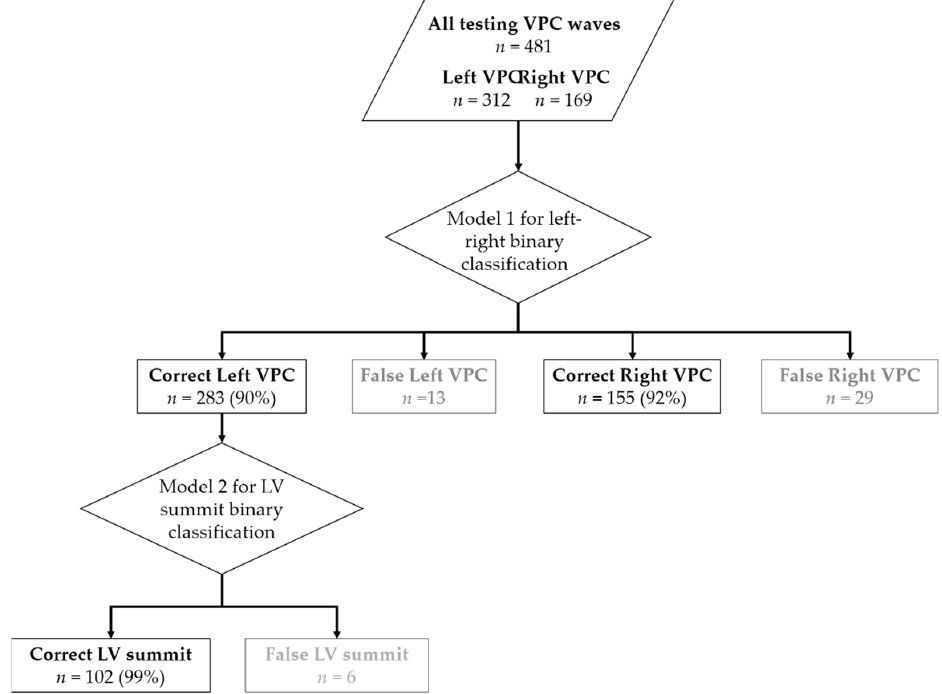
Figure 6. Combining two models for Ventricular Premature Contraction source identification. This workflow shows the performance of combining the use of two models. The percentage shown in the figure indicates the portion of waves being correctly identified. Text and frame with light color indicate false prediction.